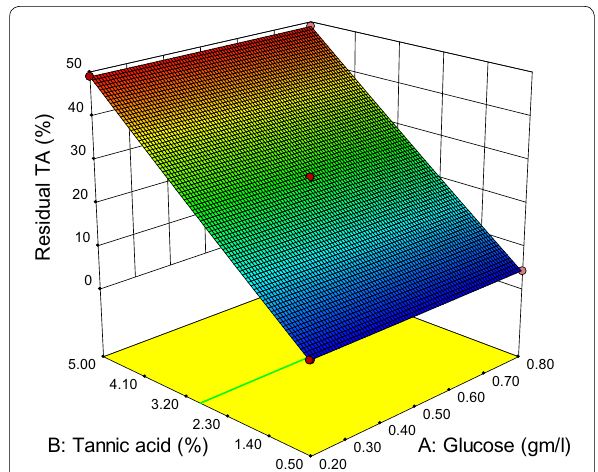
Fig. 4 Three-dimensional plot of residual tannic acid as a function of tannic acid and glucose at constant NH 4 Cl (1.0 g/L) and metal